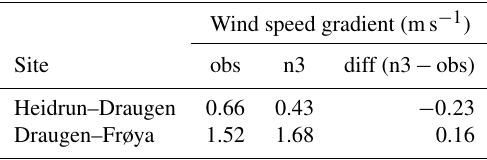
Table 7. The average change in wind speed (ms − 1 ) at sensor height per 100km for Heidrun–Draugen and Draugen–Frøya.